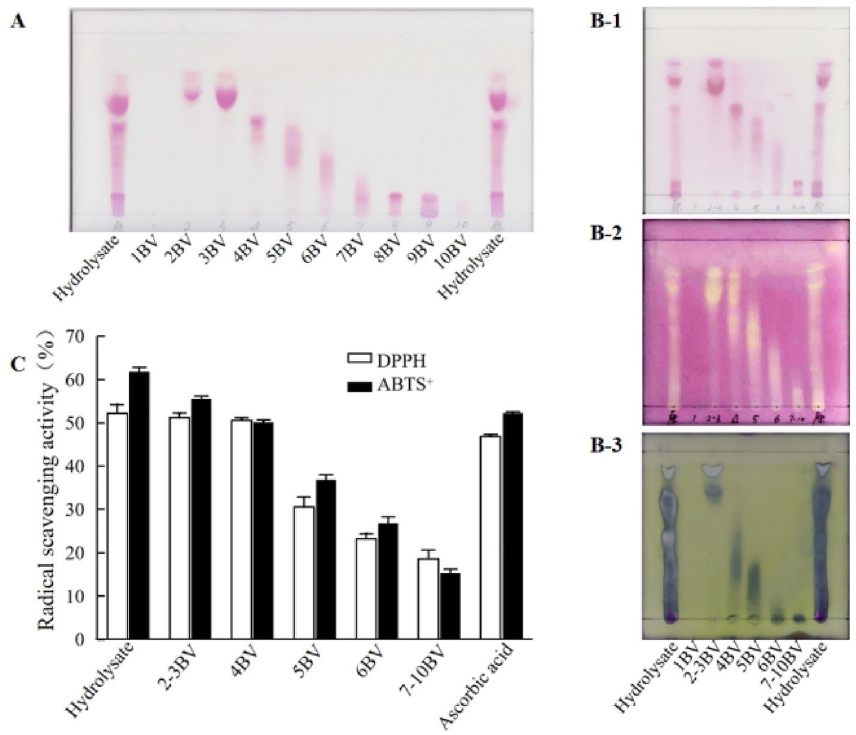
Figure 3. Analysis of the peptide fractions separated by silica gel column chromatography. ( A ) TLC analysis of different fractions of peptides eluted from the column; ( B ) TLC-bioautographic analysis of different eluents of peptides. The TLC plates were stained by ninhydrin ( B-1 ), by DPPH ( B-2 ), or by BCA solution ( B-3 ). ( C ) Quantitative analysis of antioxidant activity of different peptide fractions from the column chromatography, using ascorbic acid (0.5 mg/mL) and the hydrolysates (1.0 mg/mL) as